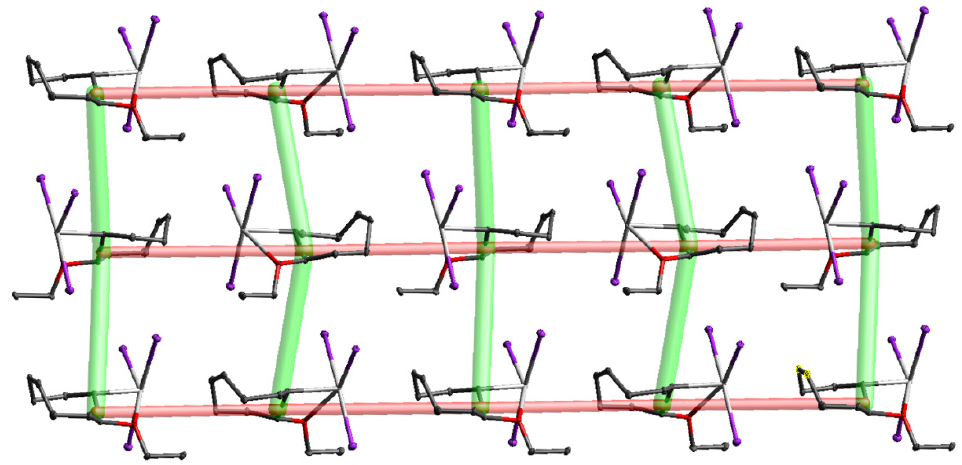
(see Figure 7c) in a pair of